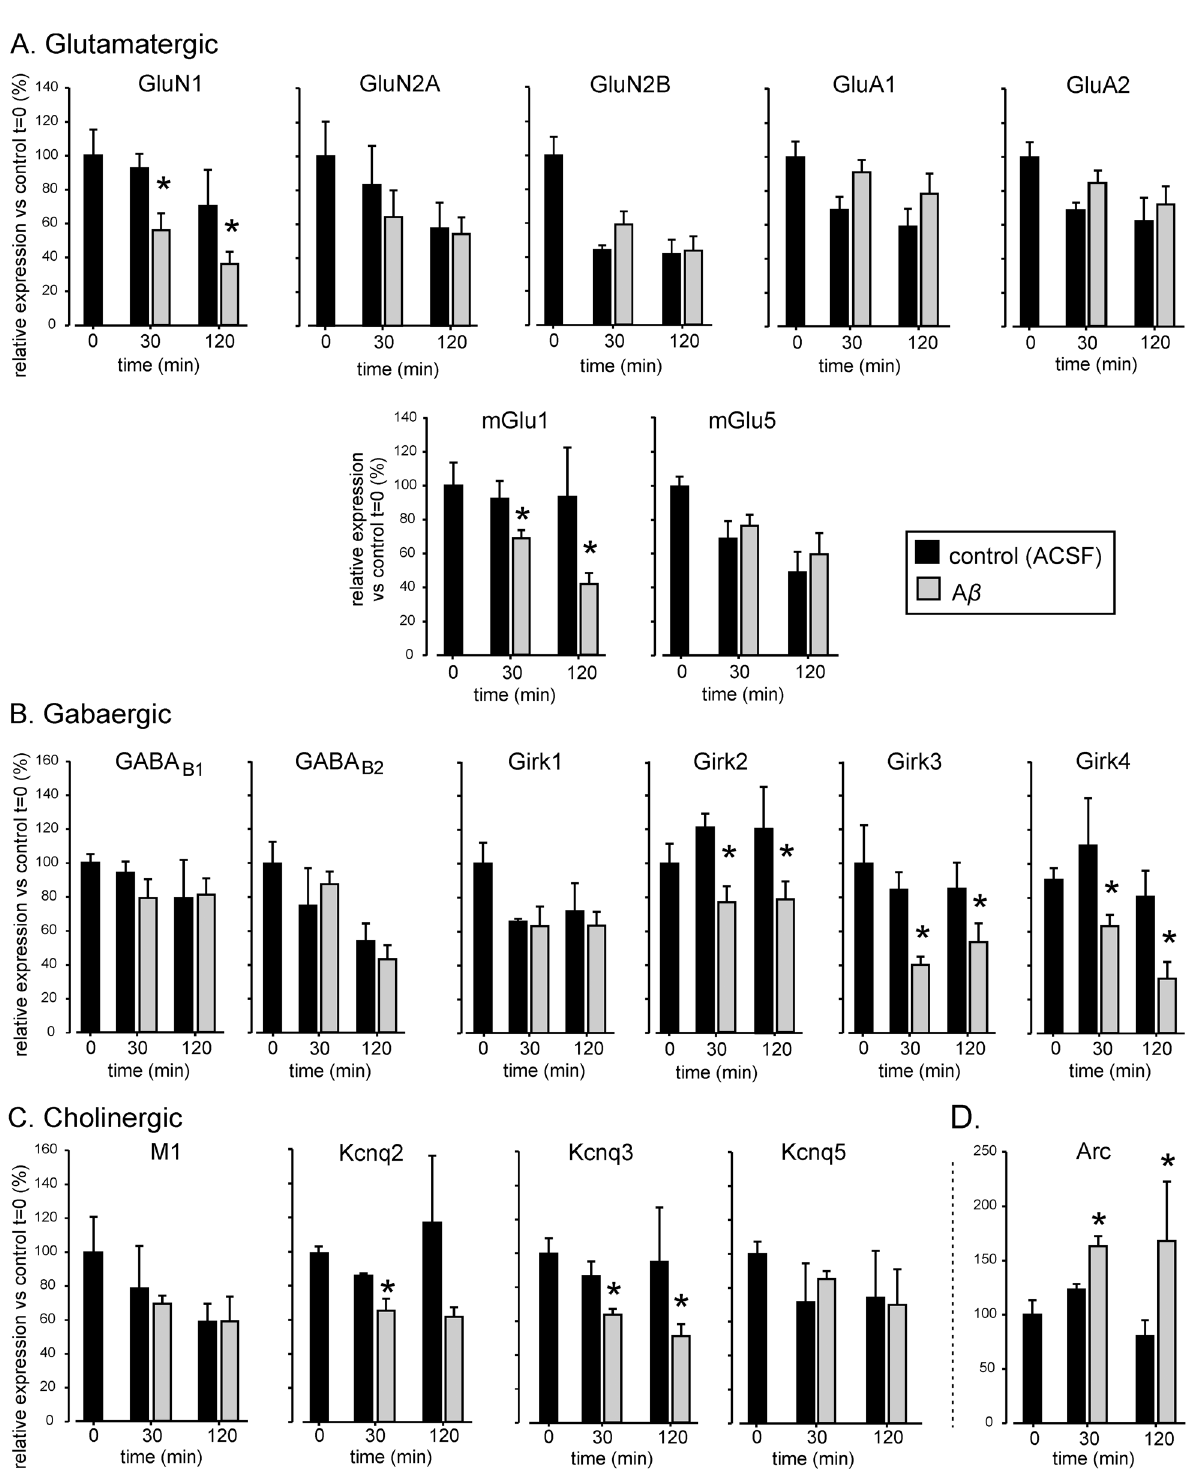
Fig 2. Relative expression of the main receptor and channel genes involved in excitatory and inhibitory hippocampal neurotransmission systems during A β incubation. Expression levels of mRNA for (A) glutamatergic (B ) cholinergic and (C) GABAergic genes, at 0, 30 and 120 min after ACSF (control) or A β incubation, were analyzed by qPCR and normalized to Ppia , the most stably expressed reference gene in our study. Normalized 2 – Δ Cq expression for each gene and time point is presented as percentage of gene expression at time 0 (t = 0 min) which is considered as 100% basal control expression. (A) . Relative mRNA expression levels of glutamatergic NMDA receptor subunits GluN1 , GluN2A and GluN2B , AMPA receptor subunits GluA1 and GluA2 , and